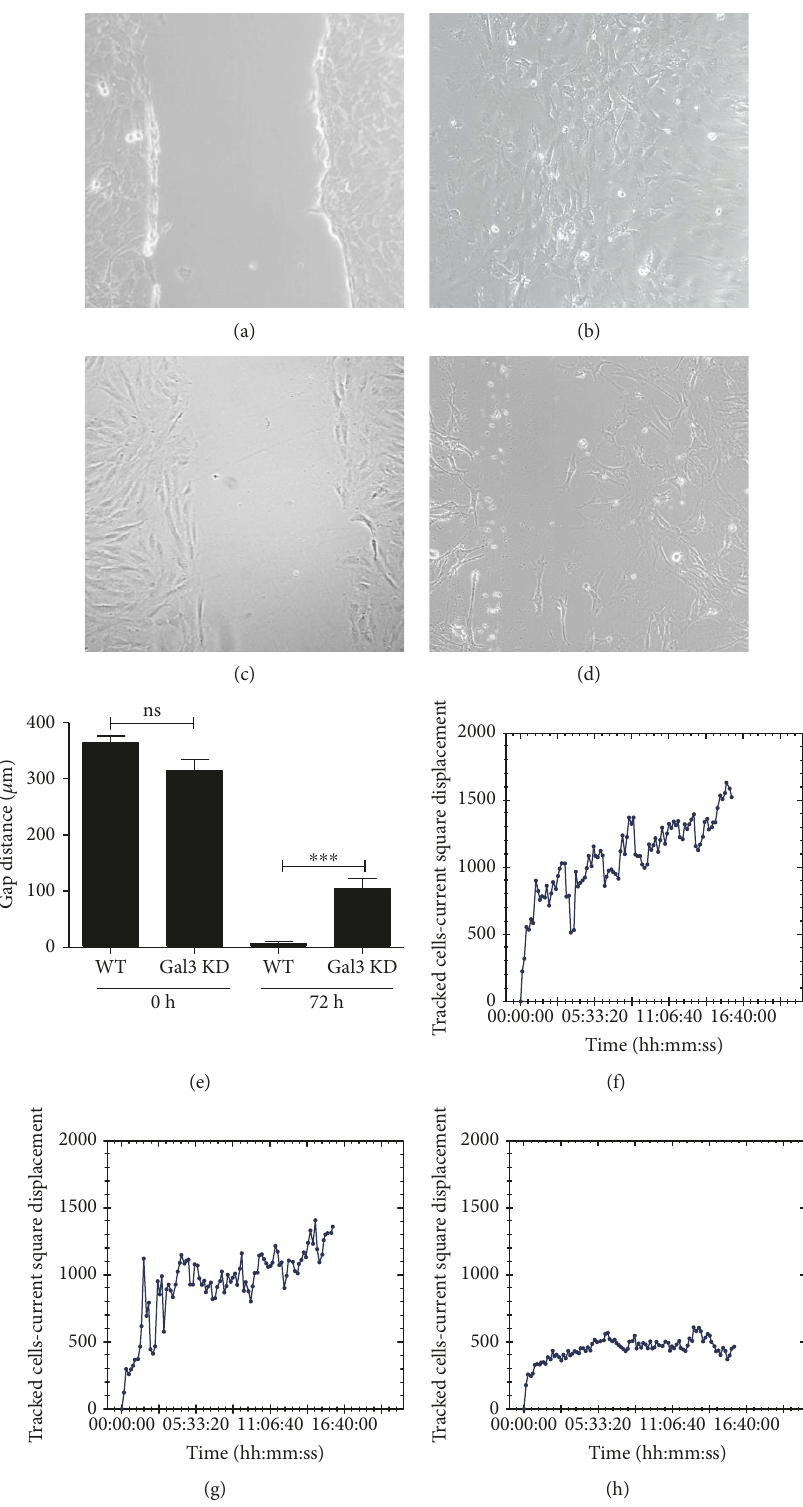
Figure 4: Gal-3 knockdown MSC exhibit defective migration and displacement in vitro. Migration was evaluated by the wound healing assay. Phase contrast representative images showing scratch area at day 0 for wild-type MSC (a) and Gal-3 knockdown MSC (c), and at day 3 for wild-type MSC (b) and Gal-3 knockdown MSC (d). (e) Gap distance was evaluated at 72h and compared to time 0. ∗∗∗ P < 0 001 . (f – h) Mean square displacements were obtained by individually tracked cells at various time points, from the time of the fi rst position, until the end of the overnight incubation of MSC-WT (d), MSC-Ctrl (e), and MSC-Gal3KD (f). MSC-WT =wild-type MSC; MSC-Ctrl=MSC transduced with a nontargeting shRNA vector; MSC-Gal3KD=Gal-3 knockdown